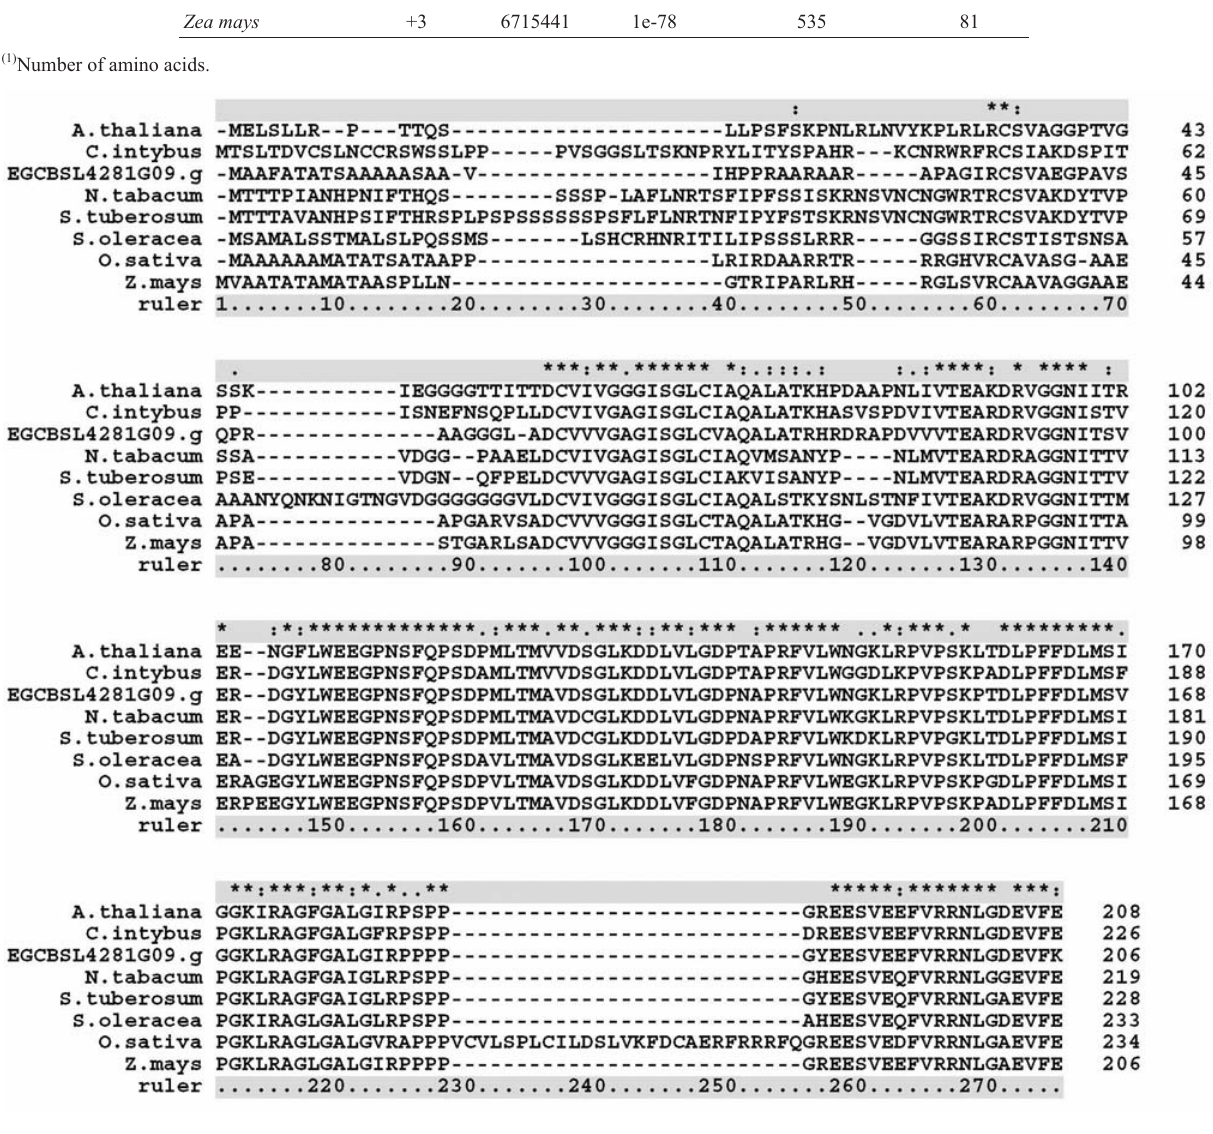
Figure 2 - Fragments of sequences corresponding to the start region of the protoporphyrinogen IX oxidase enzyme from different plant species.